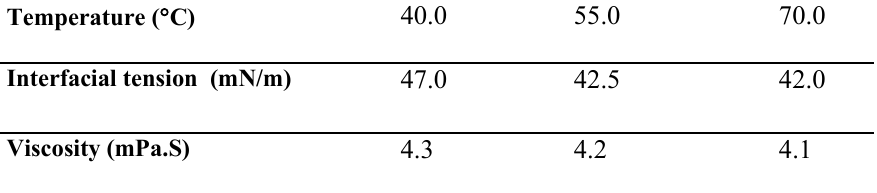
Physicochemical properties of binder solution at different temperature and mass percent of